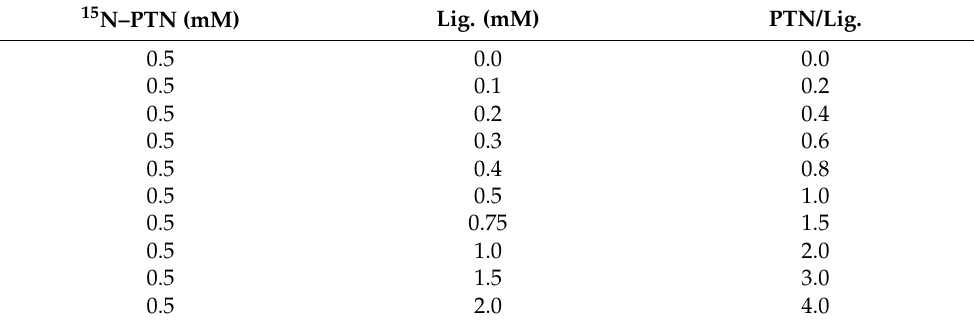
Table 2. Table with the points used for the